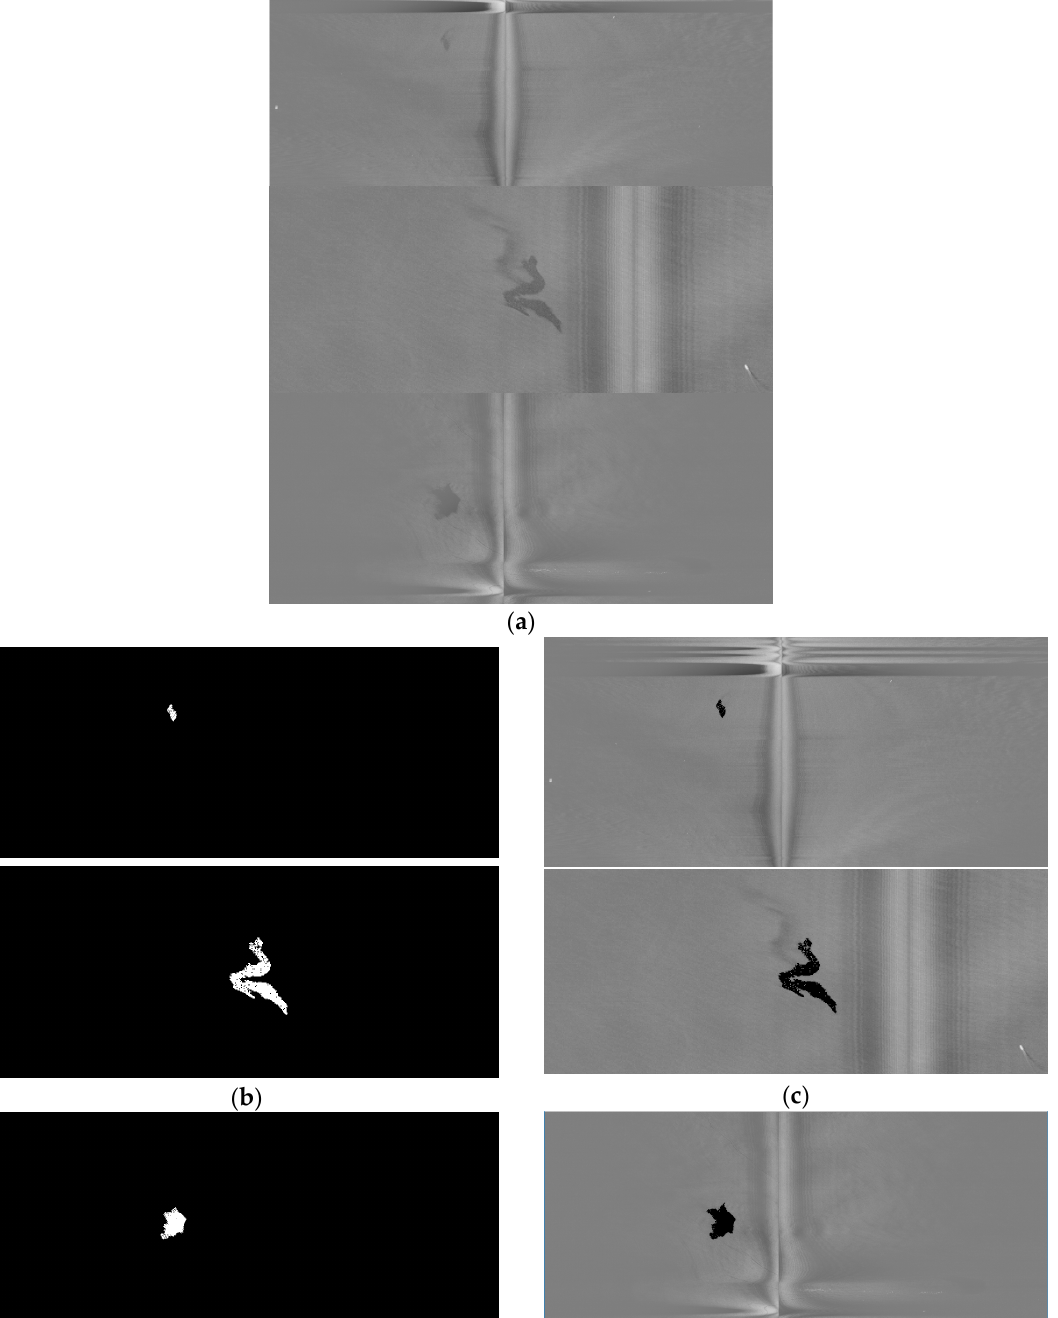
Figure 6. Results of oil-slick detection process with reconstruction: ( a ) Original SLAR image; ( b ) Ground-truth for oil slick area; ( c ) Our oil-slick detection guided by saliency maps and centroids. The ground-truth images are segmented images with human-annotation.